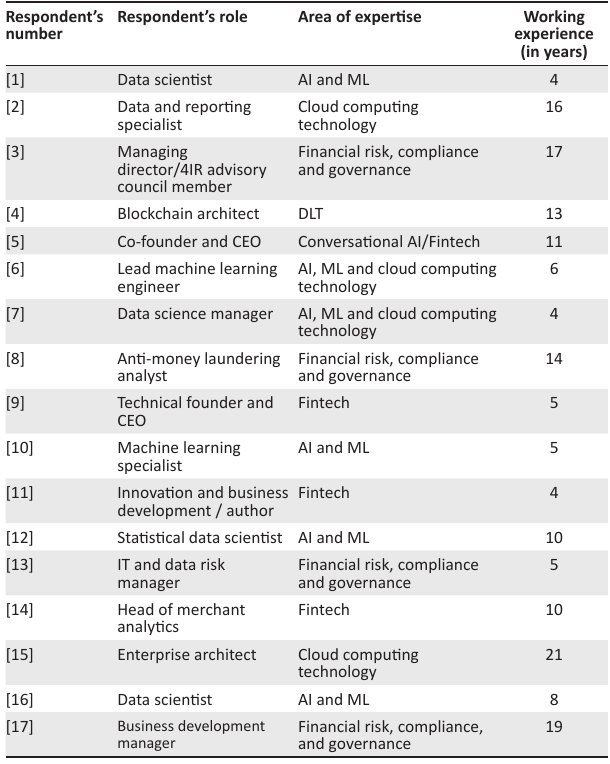
TABLE 2: Respondents’ roles, fields of expertise and